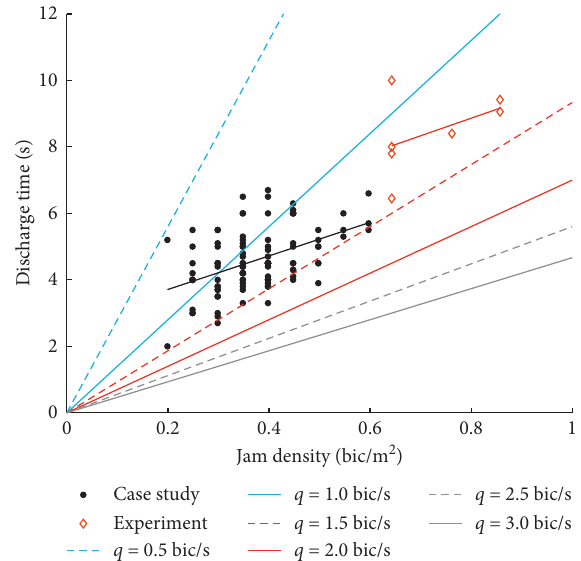
Figure 8: Combined results of the case study and